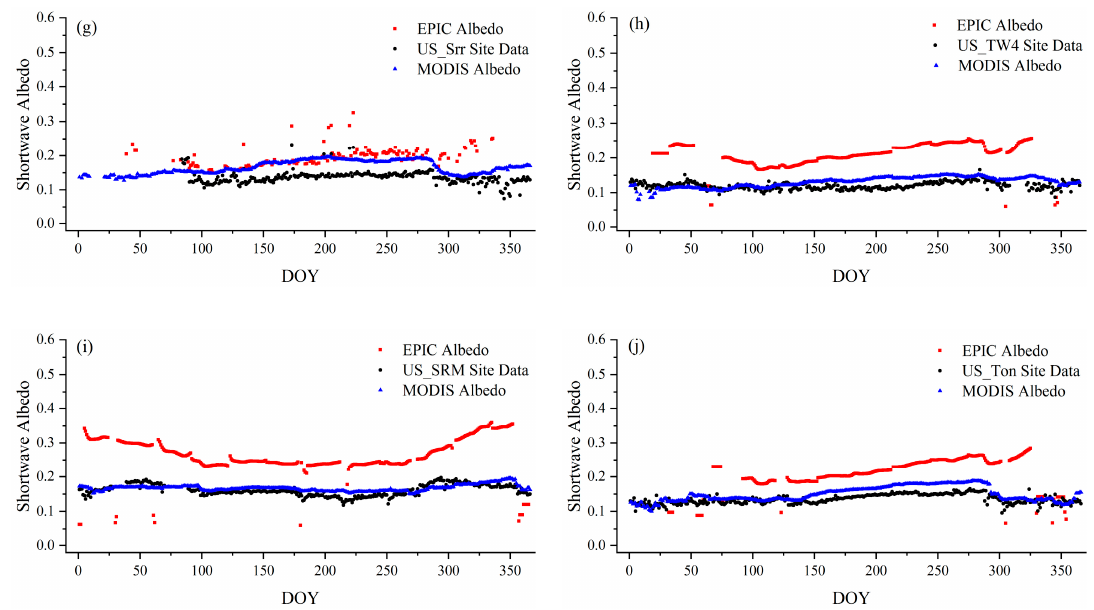
Figure 4. Time series of albedo under different typical land cover types in 2016 from EPIC, MODIS, and AmeriFlux. The land cover type of ( a )-( b ) is croplands, ( c )-( d ) is evergreen needleleaf forests, ( e )- ( f ) is grasslands, ( g )-( h ) is permanent wetlands, and ( i )-( j ) is woody savannas. DOY means day of the year.